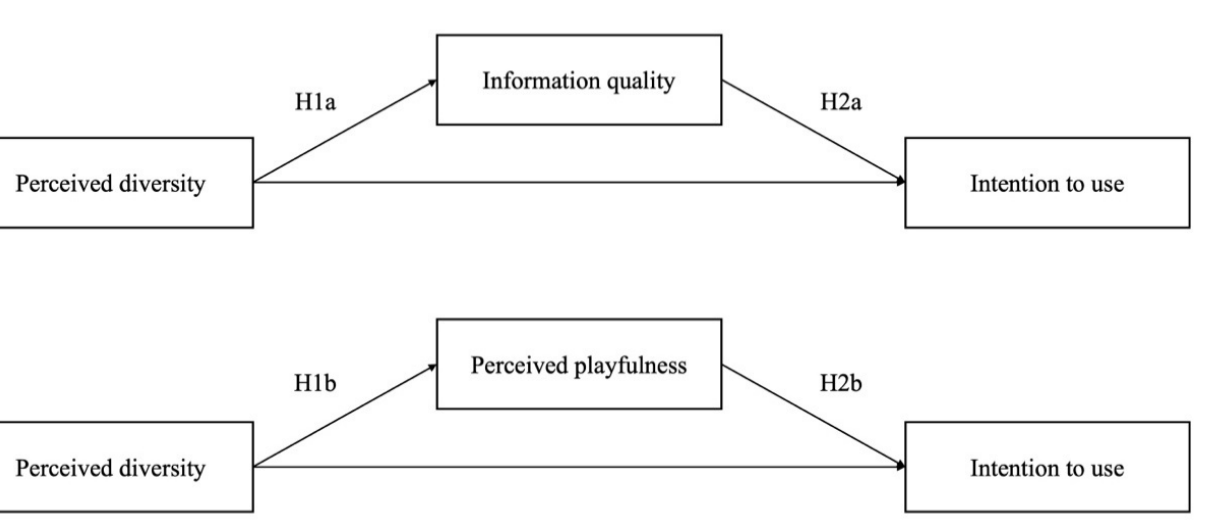
Figure 1. Hypotheses 1s and 2s.